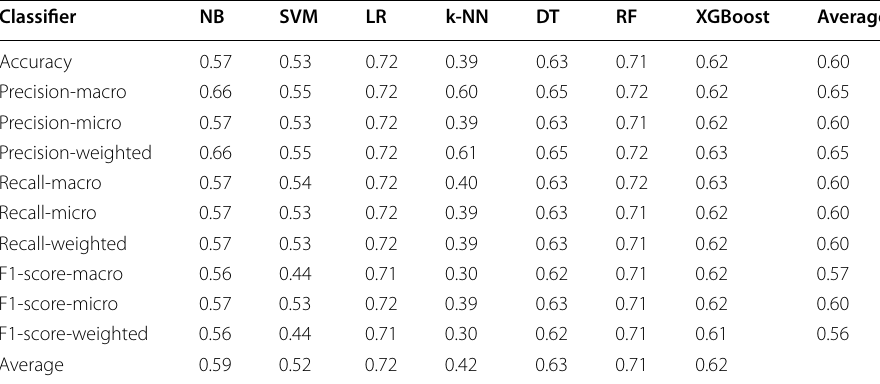
Table 9 The classification metrics for the undersampled Russian